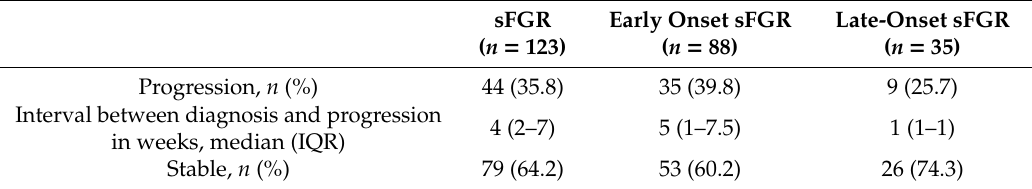
Table 3. Disease progression in dichorionic twin pregnancies complicated by selective fetal growth restriction (sFGR) according to the gestational age at